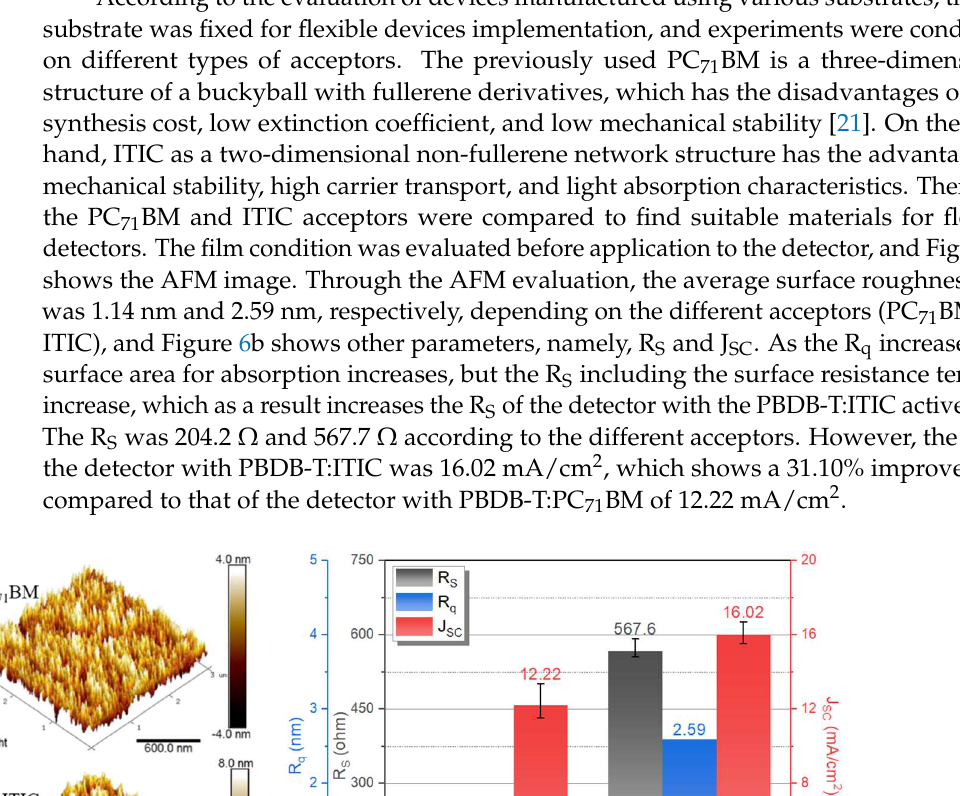
Figure 5. ( a ) J–V characteristics of photodetector with the PBDB-T:PC 71 BM active layer, and ( b ) CCD, DCD, and sensitivity of the X–ray detector on glass, CPI, and PEN substrates.